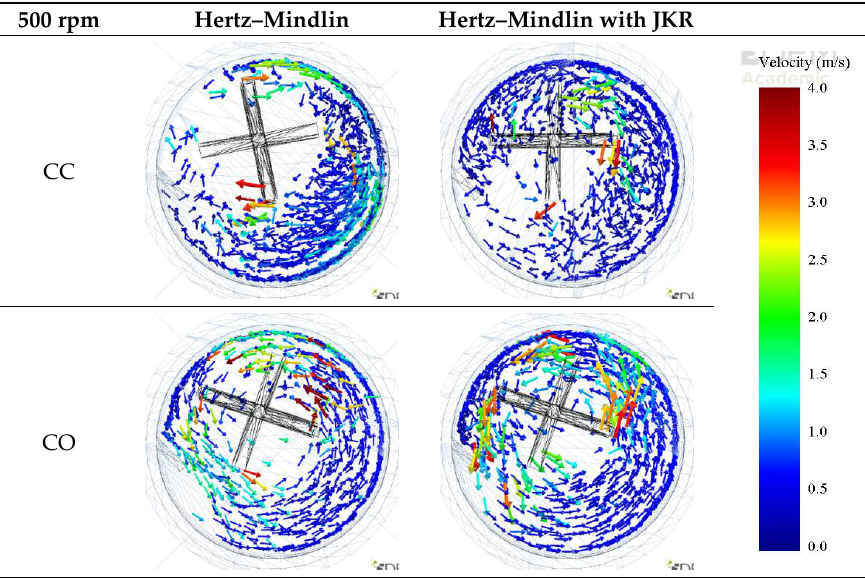
Figure 7. Top view of the comparing simulated velocities of particles for the different contact models and modes of operation for an impeller frequency of 500 rpm.